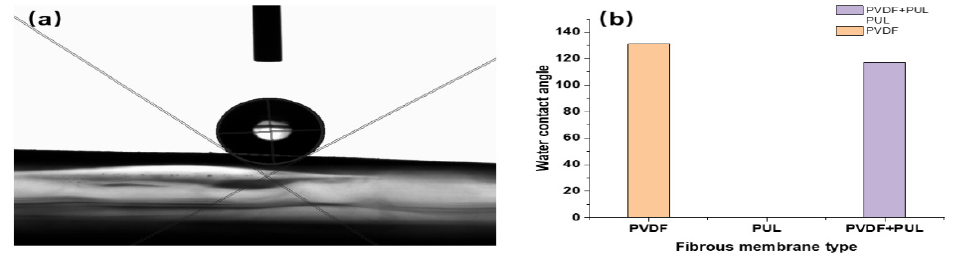
Figure 12. Water contact angle measurement of nanofiber membrane with three structures. ( a ) Water contact angle measurement; ( b ) Water contact angle comparison diagram of three types of nanofiber membranes.